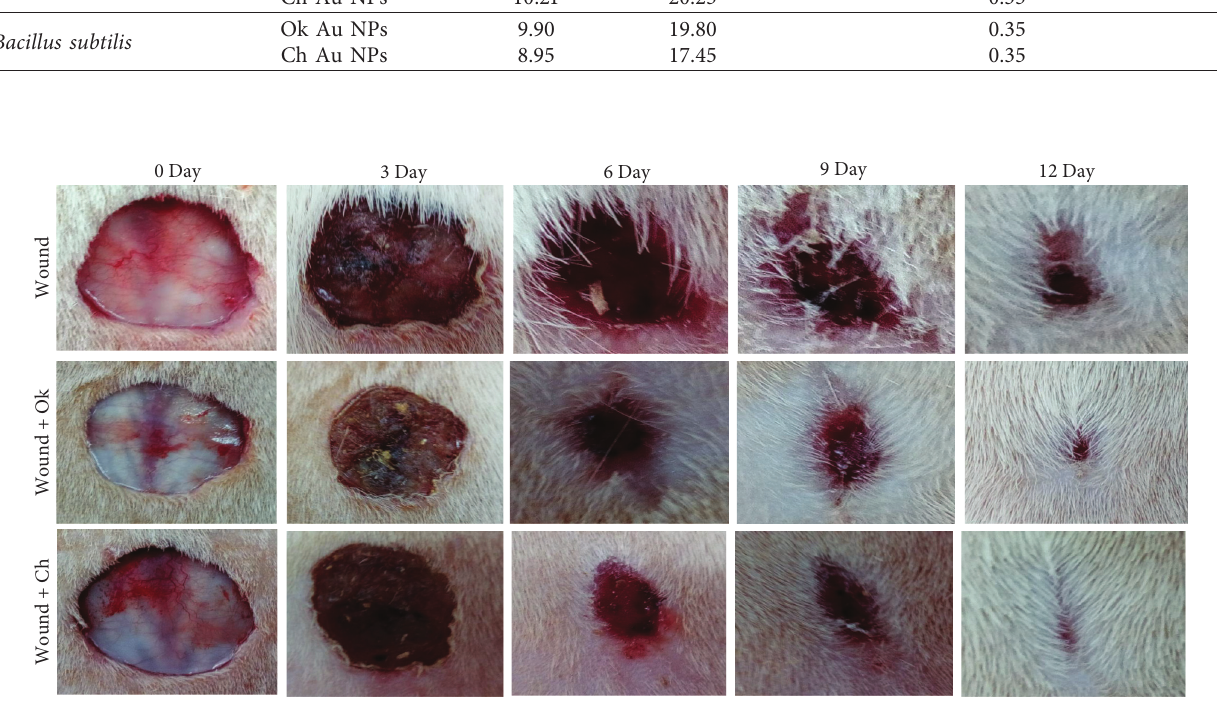
Figure 9: Wound status in the experimental